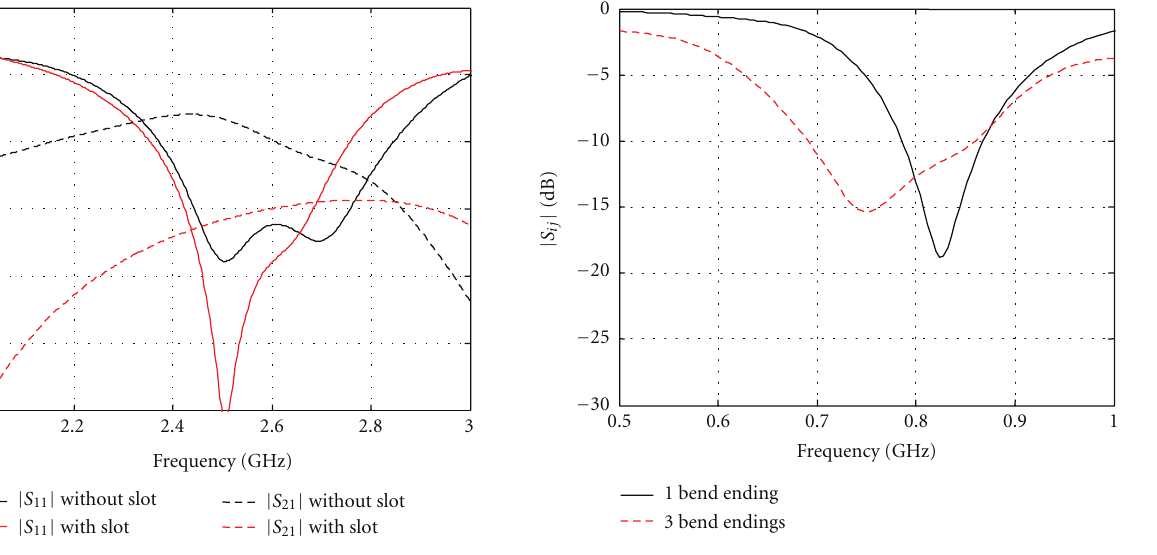
Figure 3: Simulated | S ij | parameters of one meander bend ending antennas with added ground plane, with and without slot in the higher band.